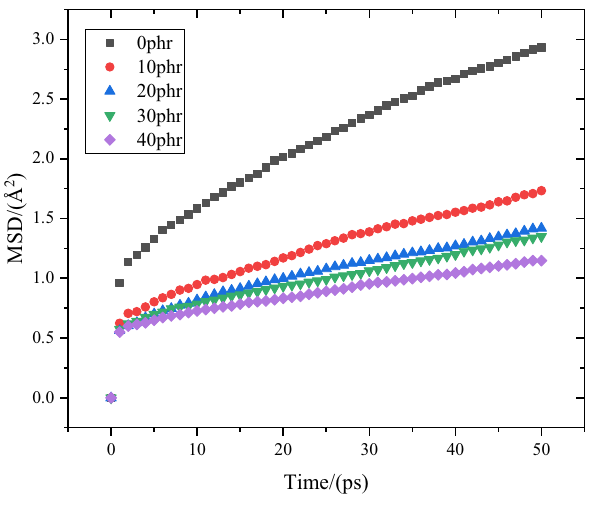
Figure 9: EP composite MSD with di ff erent h - BN